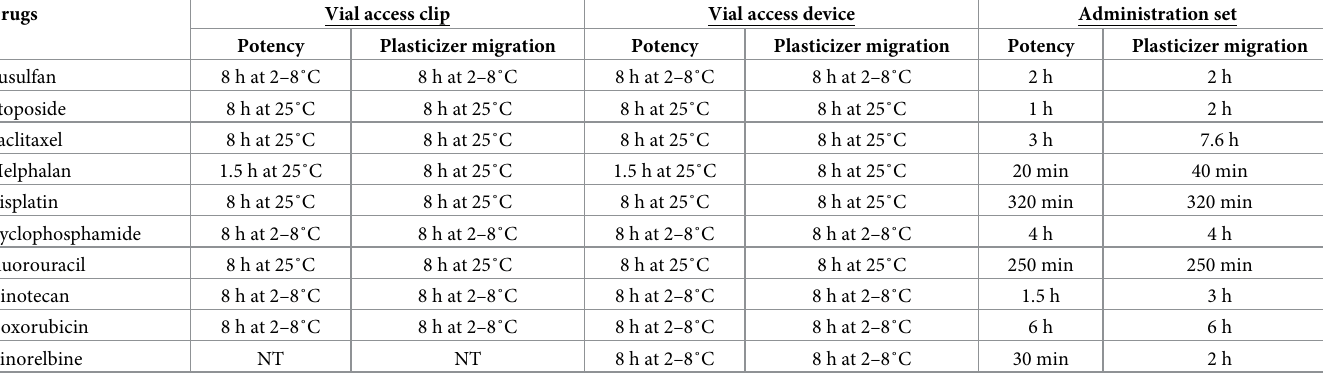
Table 1. Storage durations and conditions of the reconstituted vials and diluted infusion bags before the sampling for potency maintenance and plasticizer migra- tion tests.